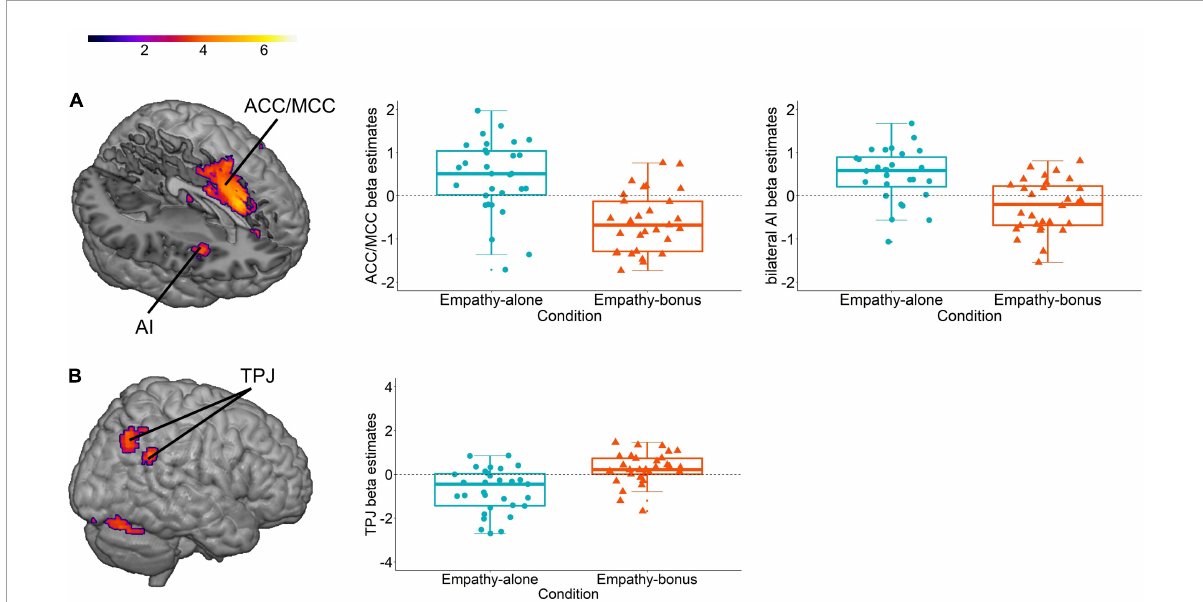
FIGURE1 Neural response during prosocial decisions (1% uncorrected cluster-based inference with p < 0.001 cluster-forming threshold; k = 0). We used data ( N = 31) from Iotzov et al. (21) and reanalyzed them for the purpose of this review. (A) Neural contrast between prosocial decisions in the empathy-alone vs the empathy-bonus condition and visualization of the average beta-values extracted from the clusters of activation in the bilateral anterior insula (AI; center co-ordinates left x = –36, y = 14, z = 8 and right X = 30, y = 11, z = –16) and the anterior and mid cingulate cortex (ACC/MCC; center co-ordinates x = –9, y = 14, z = 35). (B) Neural contrast between prosocial decisions in the empathy-bonus vs the empathy-alone condition and visualization of the average beta-values extracted from two clusters of activation in the temporal parietal junction (TPJ; center co-ordinates x = –45, y = –55, z = 32 and x = –36, y = –70, z =